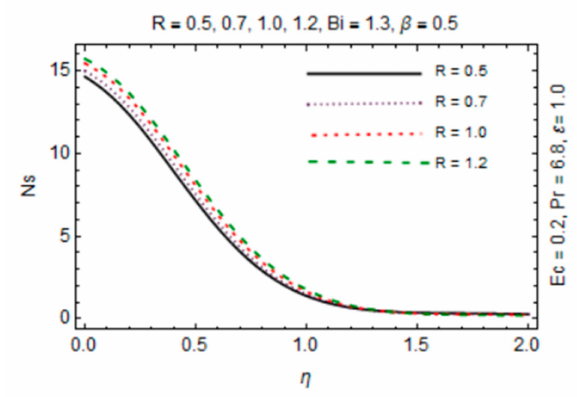
Figure 18. R verses entropy generation number.